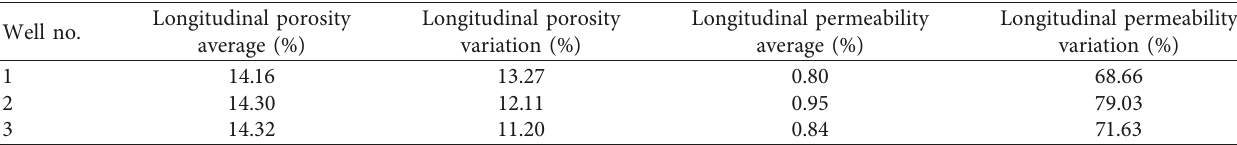
Table 2: Variation of porosity and permeability of tight reservoirs in the longitudinal direction. Well